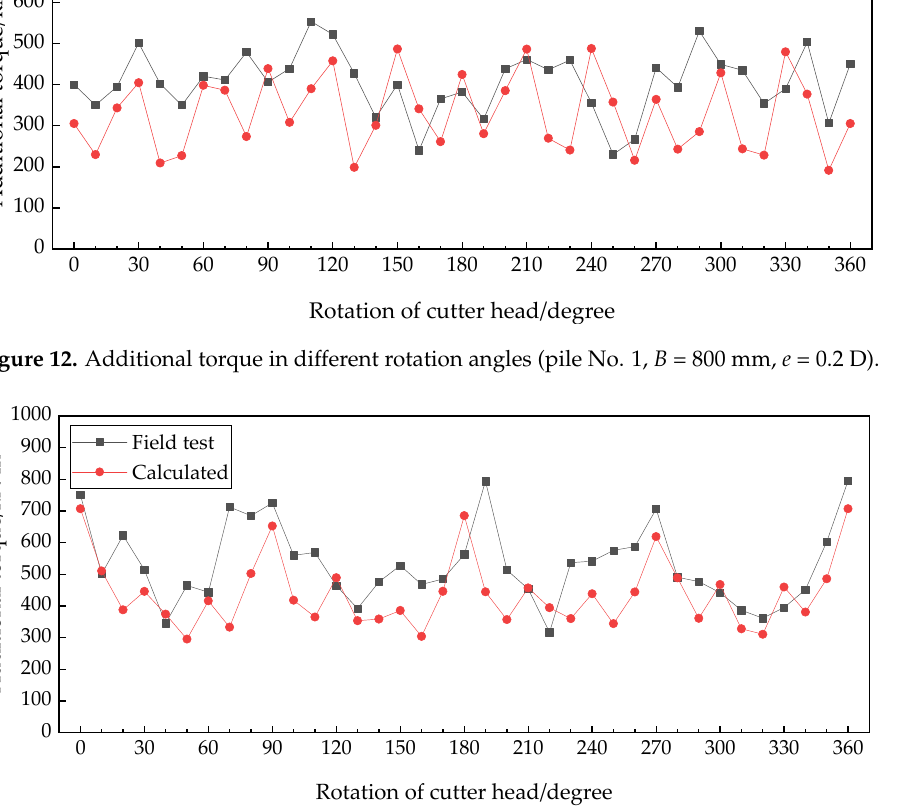
Figure 13. Additional torque with different rotation angles (pile No. 2, B = 1200 mm, e = 0).